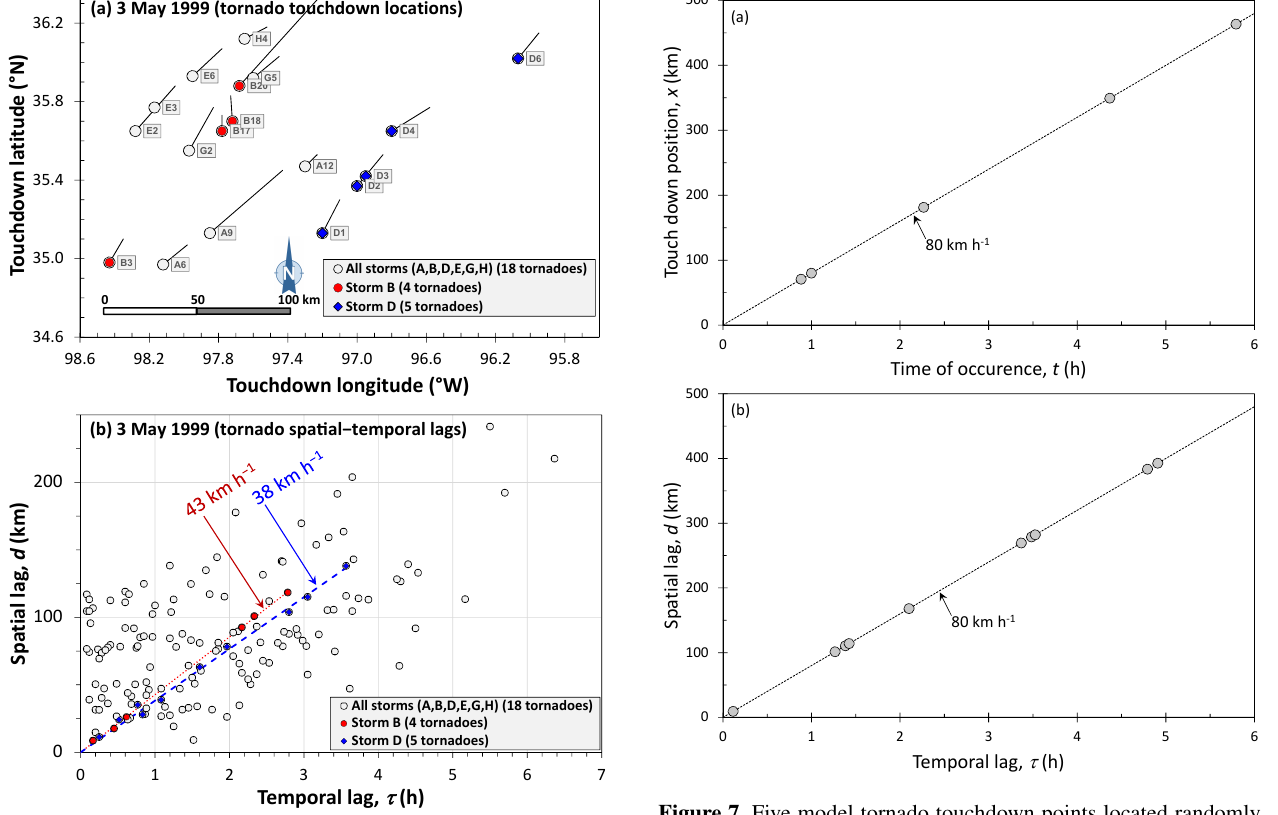
Figure 6. Tornado outbreak on 3 May 1999 (convective day, 06:00– 06:00CST). (a) Touchdown locations of 18 severe ( L ≥ 10km) tor- nadoes, with storms A, B, D, E, G, H responsible for the tornadoes identified. (b) Spatial–temporal lag correlations between the touch- downs for (i) all 18 tornadoes given in (a) , (ii) four tornadoes from Storm B, (iii) five tornadoes from Storm D. Also given are the best- fit lines for spatial–temporal lags for both Storms B and D. Data were obtained from NOAA (1999, 2015).